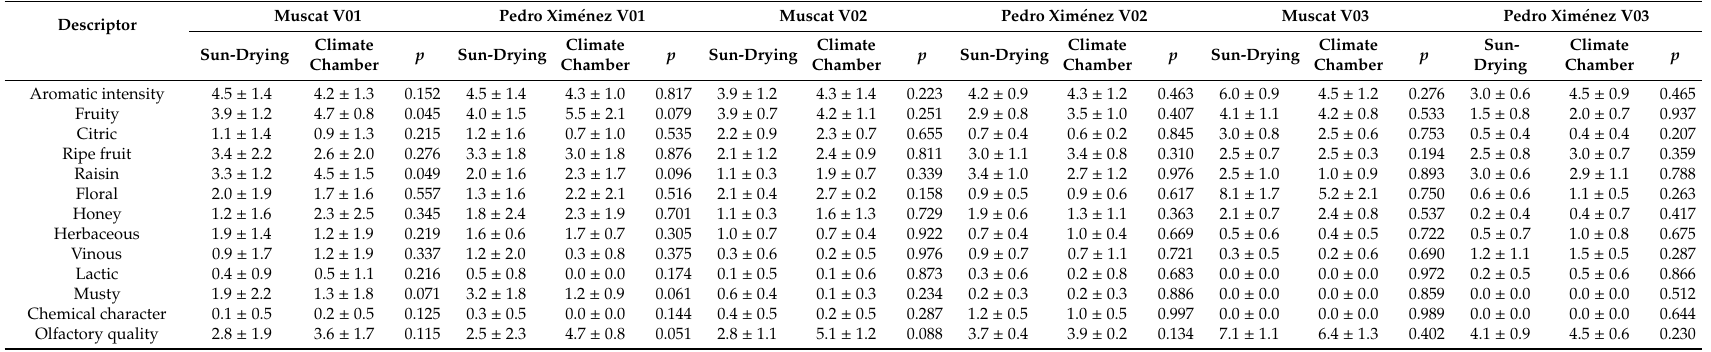
Table 3. ANOVA of sensory scores of musts, vintages 01–03. Values are expressed as average ± standard deviation. Di ff erences are significant at p < 0.05.